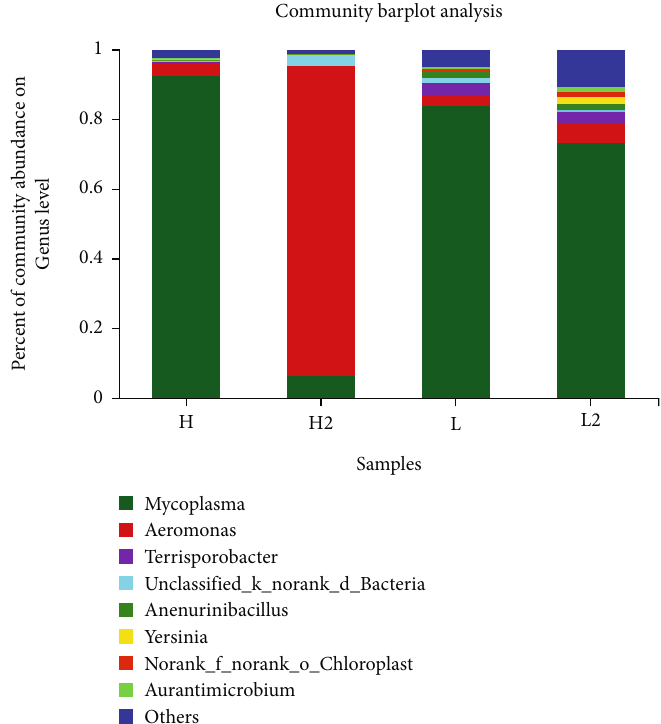
Figure 3: Intestinal microbiota community abundance of rainbow trout at genus level. H: high fi shmeal group; H2; high fi shmeal +2.0 g/kg NaB, L: low fi shmeal group; L2: low fi shmeal +2.0 g/kg